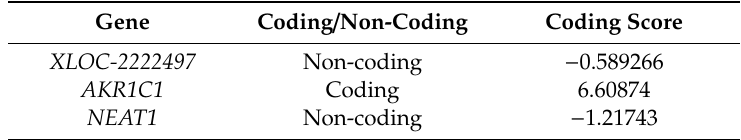
NEAT1 Non-coding